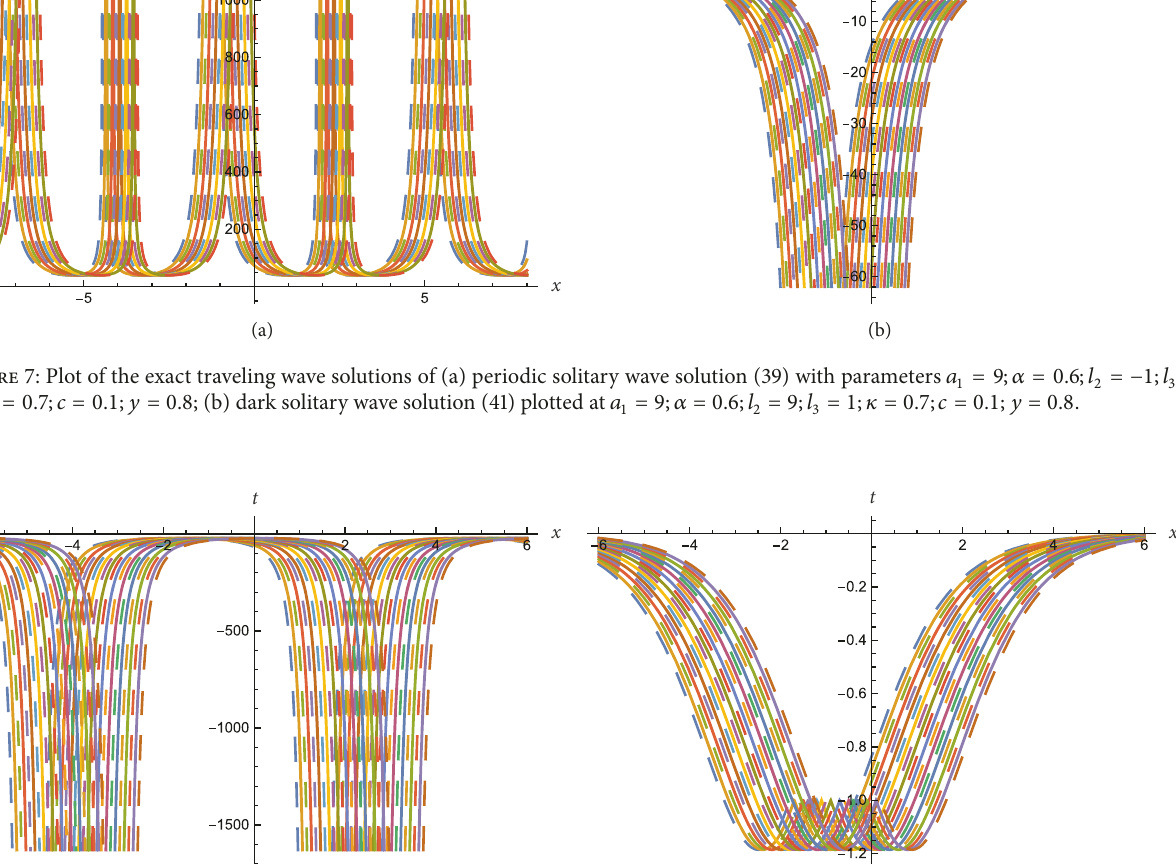
= 1;𝛼 = 0.6;𝑙 = 1; 𝑙 = 1;𝜅 = 0.7; 𝑐 = 0.1; 𝑦 = 0.8 . 1 2 3